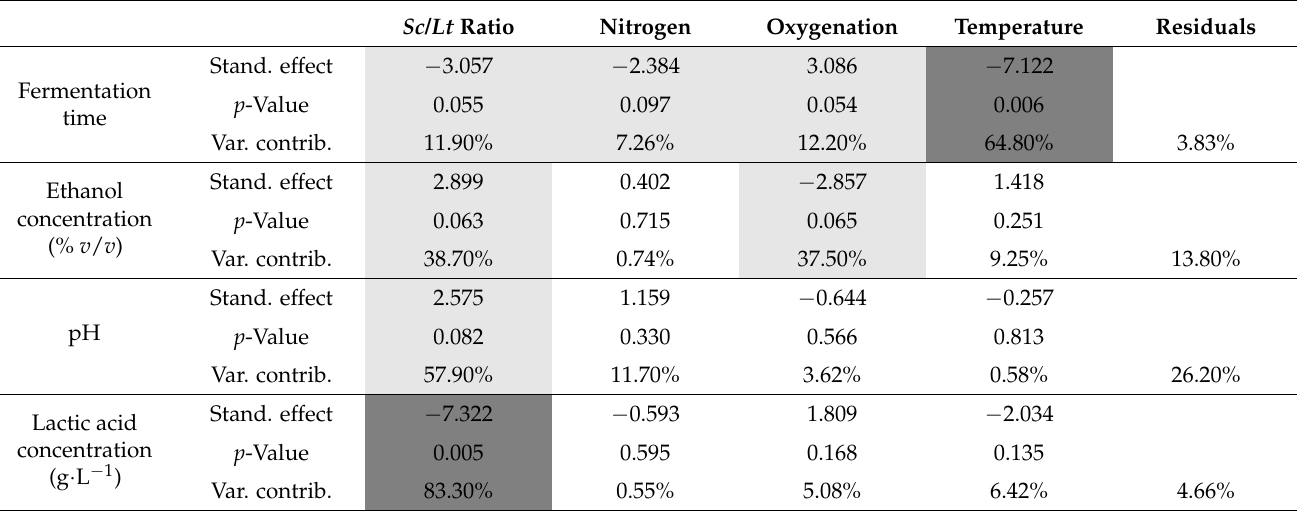
Table 4. Impact of parameters on